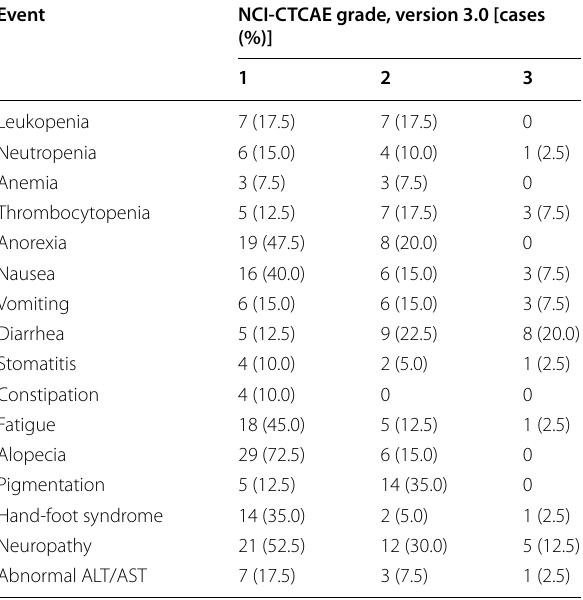
Table 3 The adverse events in the 40 Chinese patients with mCRC treated with the SOL